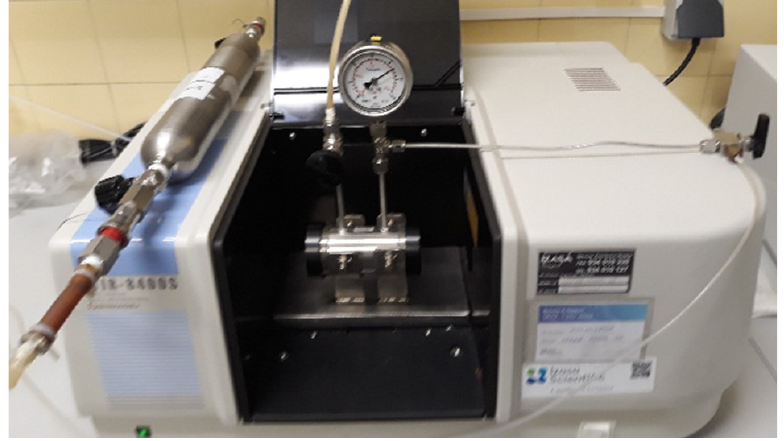
Figure 4. Instrumental setup with a gas cylinder connected to the 3-way valve so that the sample and the broadening gas can be introduced into the cell.